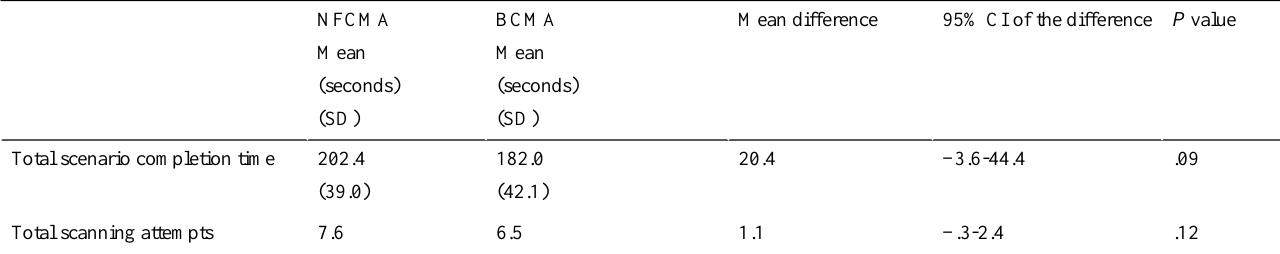
Table 3. Summary of quantitative results comparing the efficiency of the prototype near field communication-enabled medication administration (NFCMA) system to barcode-enabled medication administration (BCMA)